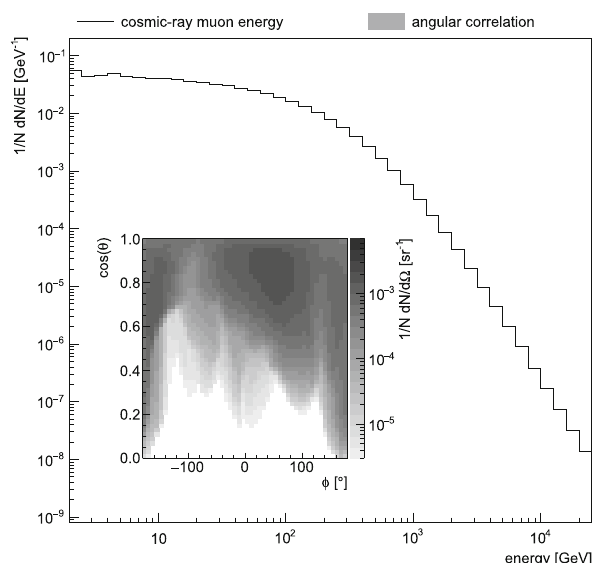
Fig. 2 Energyspectrumandazimuth/zenithanglecorrelationofmuons produced by the Musun [35] code to imping the Gerda setup